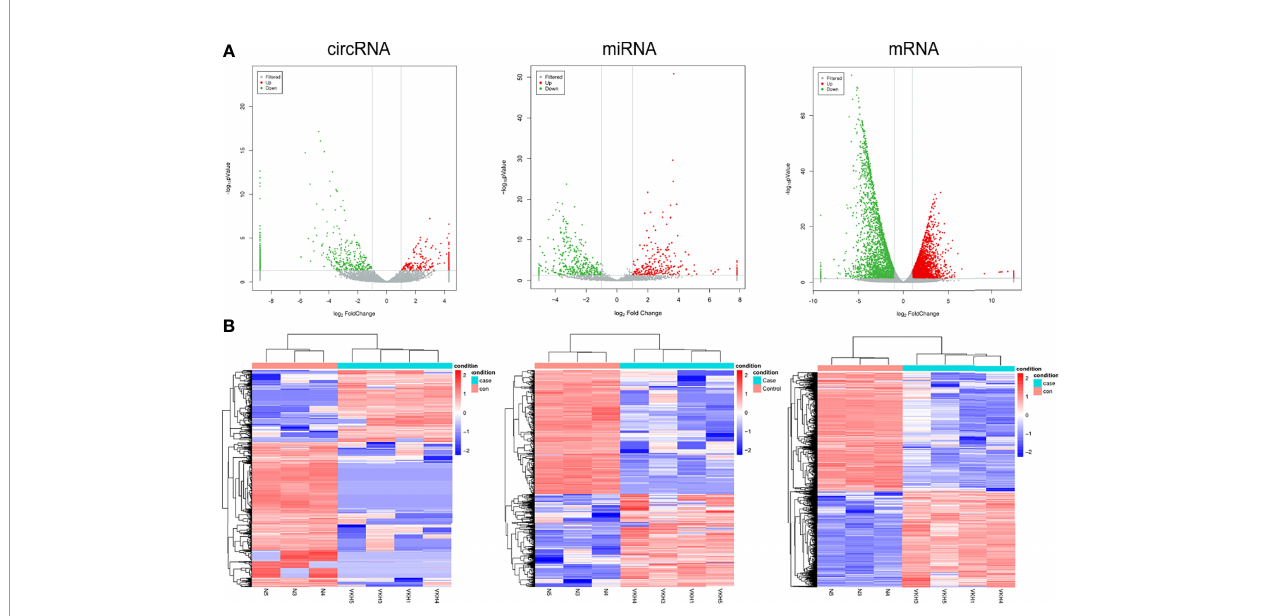
FIGURE 3 | Expression Pro fi les of circRNAs, miRNAs, and mRNAs in active VKH patients and healthy controls. (A) Cluster analysis of differentially expressed circRNAs, miRNAs and mRNAs. Red indicates high expression and blue represents low expression (B) The volcano plot of differentially expressed circRNAs, miRNAs and mRNAs.